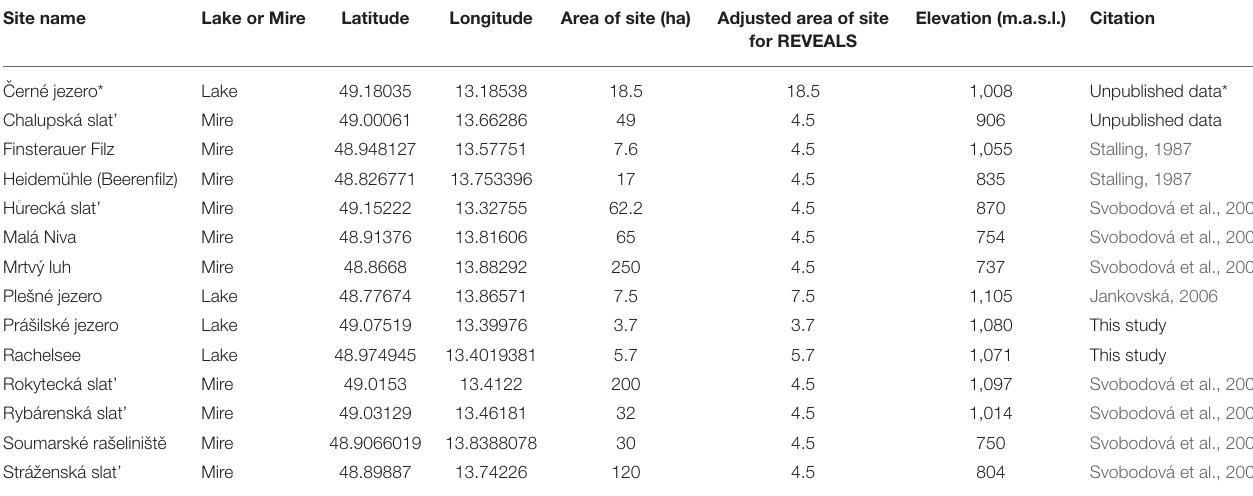
TABLE 2 | Regional sites uded to create the REVEALS pollen-based vegetation